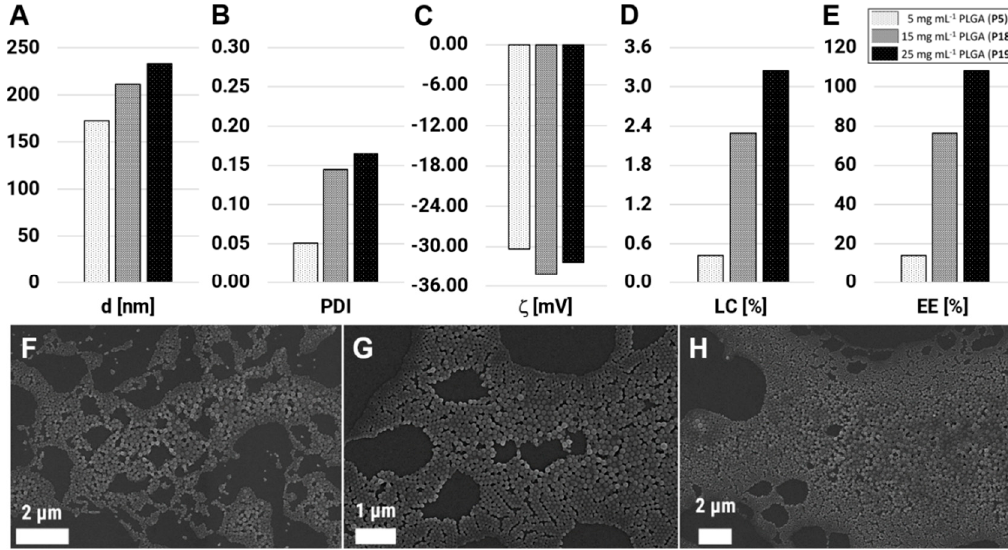
Figure 4. Nanoparticles sizes ( A ), polydispersity (PDI) values ( B ), zeta potentials ( ζ ) ( C ), final loading capacities (LC) ( D ), and encapsulation efficiencies (EE) ( E ) of PLGA(BRP-187) particles prepared with an initial polymer concentration of 5, 15, and 25 mg mL − 1 and 3% ( w / w PLGA) of initial drug loading.